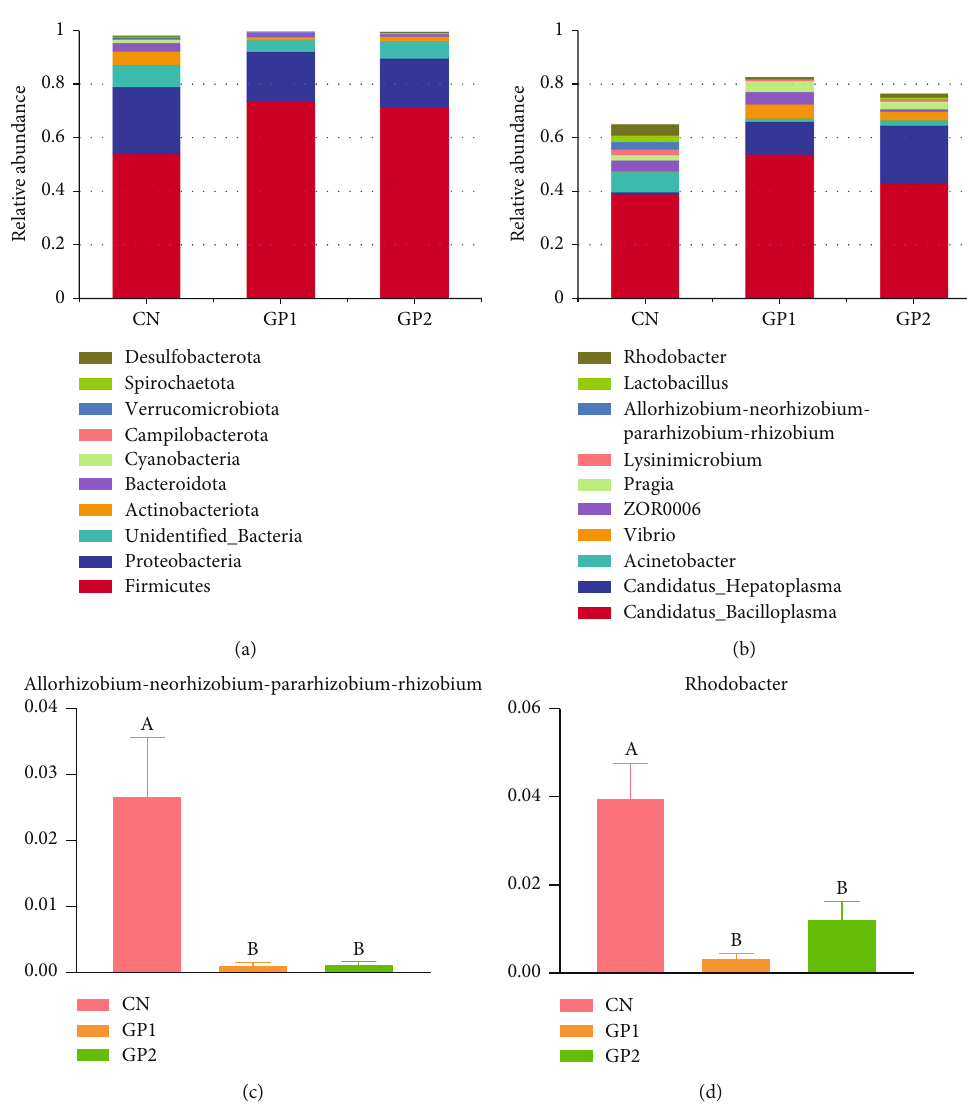
Figure 6: E ff ects of garlic powder inclusion on micro fl ora of intestinal content in Chinese mitten crabs. Bars assigned with di ff erent superscripts are signi fi cantly di ff erent ( P < 0 : 05 ). (a) Phylum; (b – d)